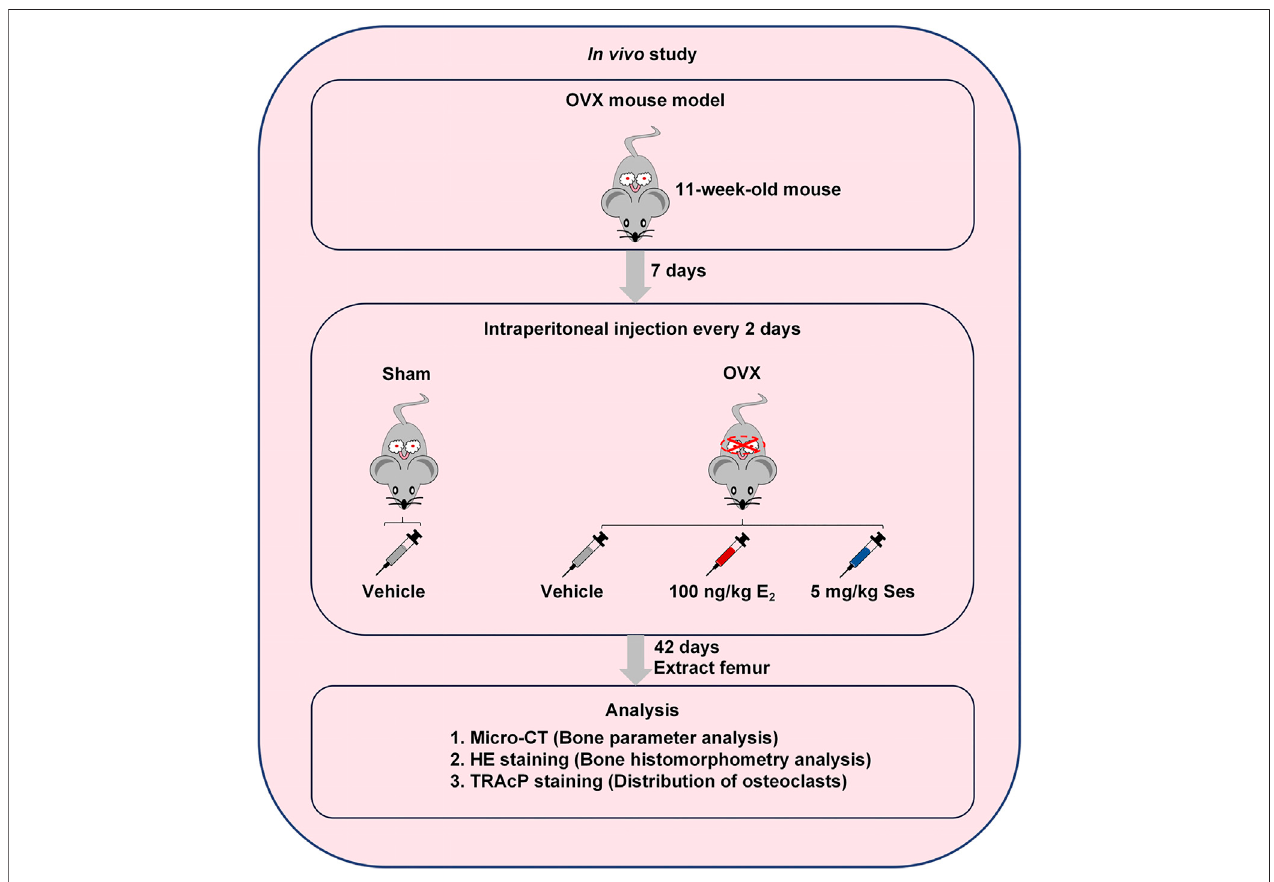
FIGURE7| EstablishmentofanosteoporosismodelofOVXmiceandanexperimentaldesigntoevaluatetheef fi cacyofSes.Ses,sesamolin;Vehicle,1%DMSOin PBS; E 2 , estrogen; HE, hematoxylin and eosin; TRAcP, tartrate-resistant acid phosphatase.